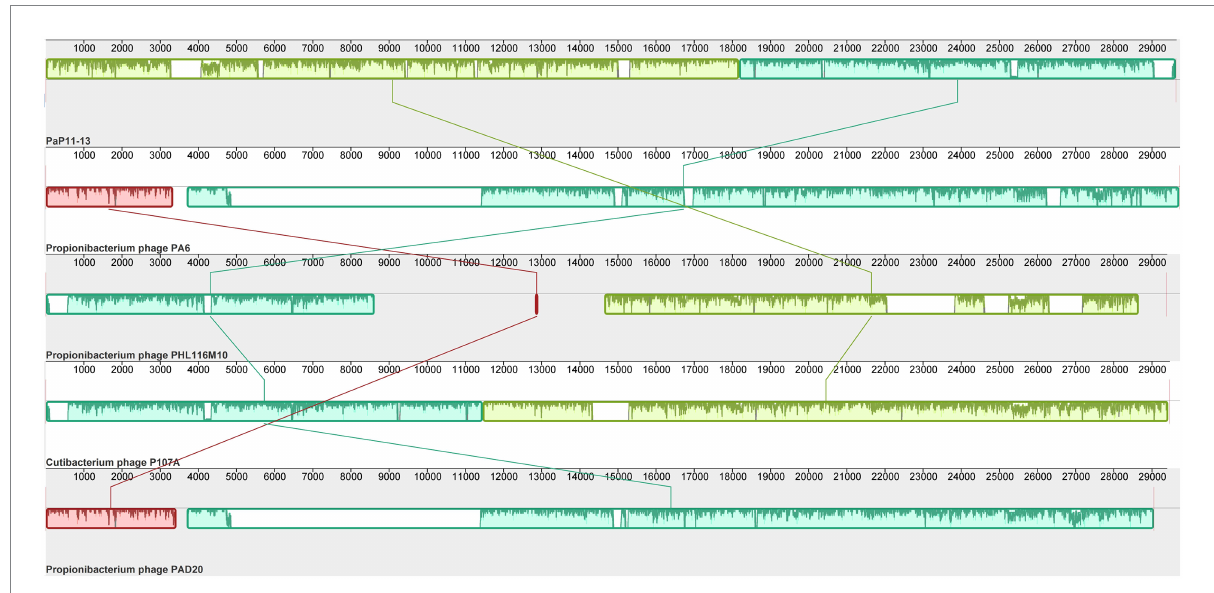
FIGURE 8 Collinearity analysis of φ PaP11-13. From top to bottom are φ PaP11-13, φ PA6(98%), φ PHL116M10(97%), φ P107A(96%), φ PAD20 (95%). The same color block represents the LCB. Blank regions inside and outside the LCB region represent regions of difference between